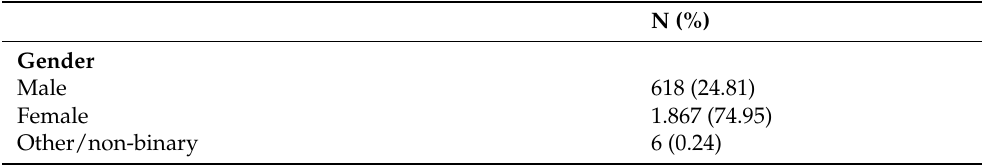
Table 2. Demographic